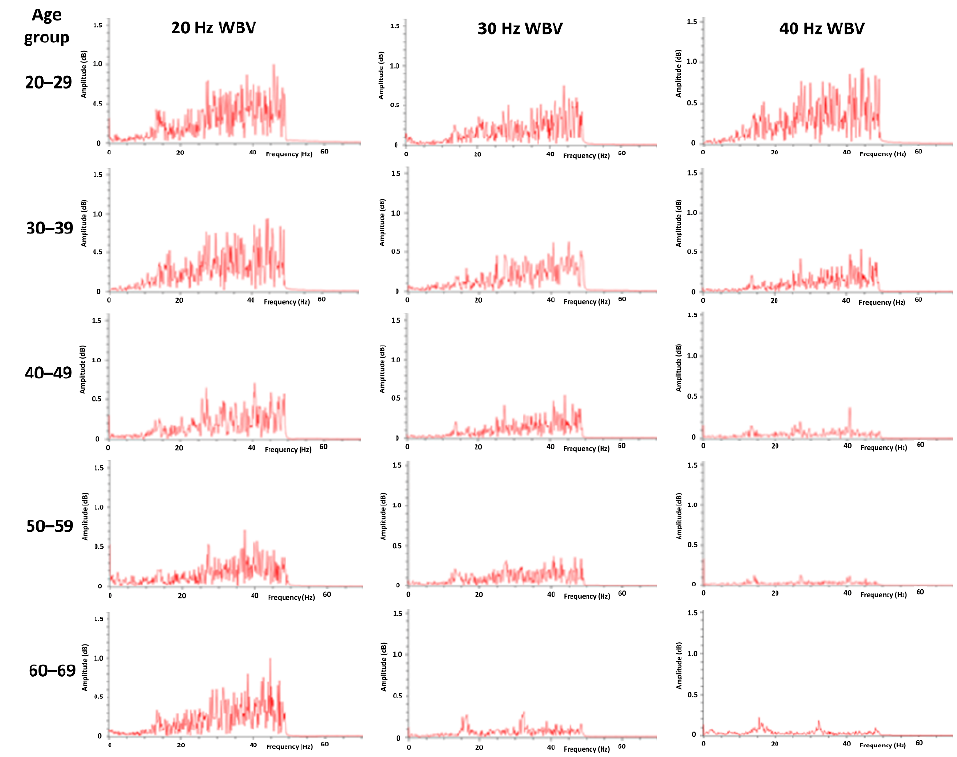
Figure 2. The frequency spectrum of a typical case of rectus femoris muscle EMG signals of different age groups during whole-body vibration at different frequencies.